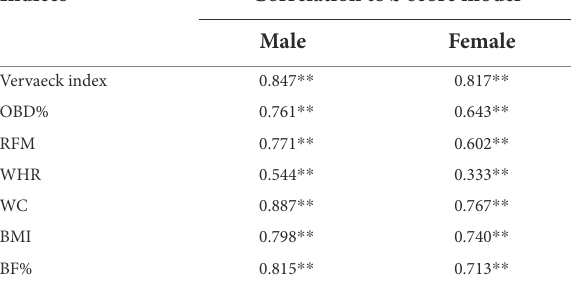
TABLE 3 Correlation coefficients of anthropometric indices to the z -score model.